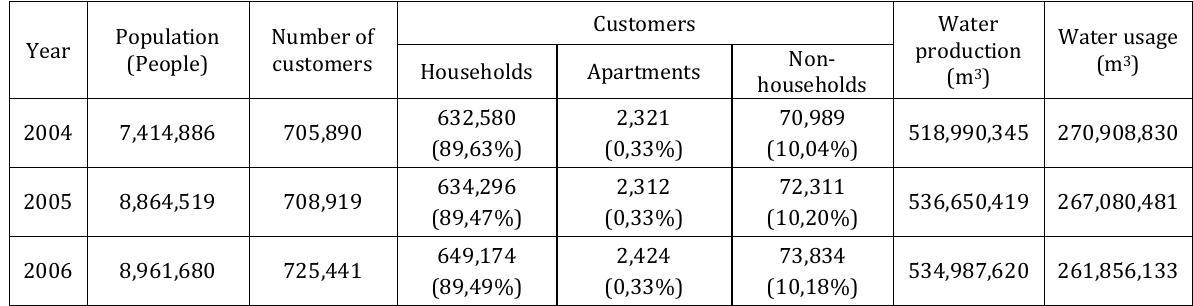
Table 4. Number of Customers and their Water Use before the Implementation of the Progressive